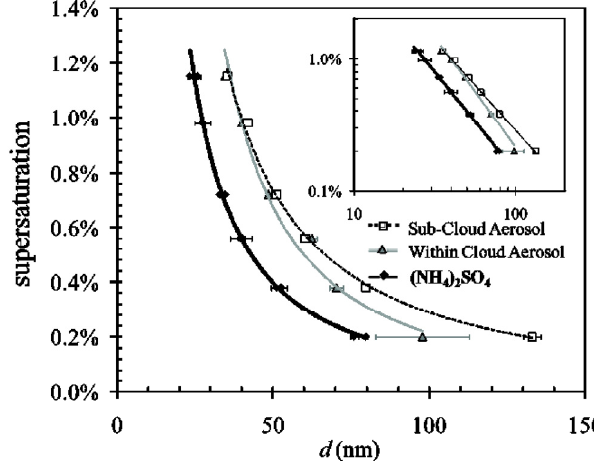
Figure 4. CCN activity of SC and CR samples. (NH 4 ) 2 SO 4 (solid black line) is added for comparison. The CCN activity curve exponents for (NH 4 ) 2 SO 4 , CR, and SC are − 1.51, − 1.66, and − 1.35, respectively.